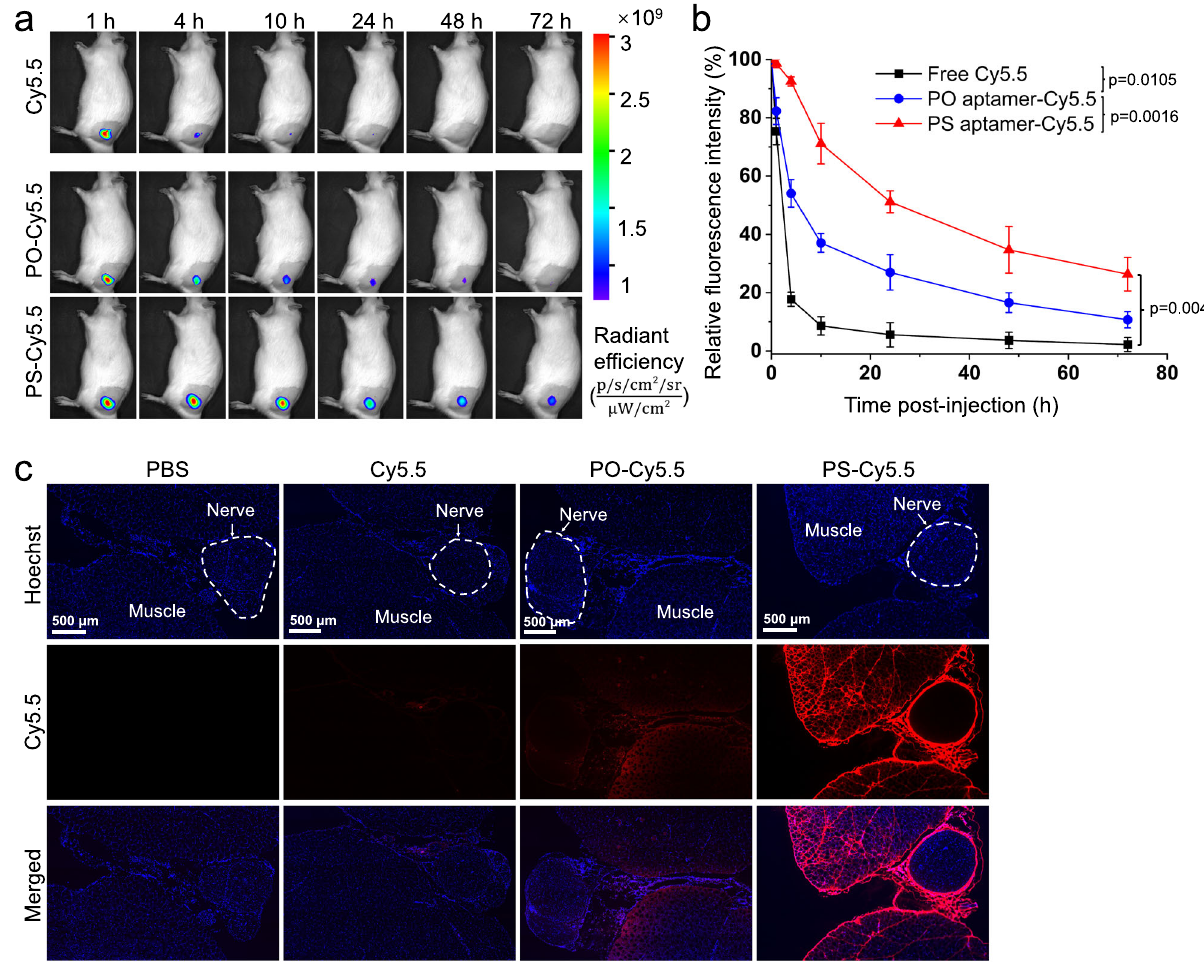
Fig. 3 | Tissue distribution of PS aptamer. a Representative time courses for the retentionofCy5.5-labelled aptamers(PO or PS)orfree Cy5.5atthe site ofinjection asmonitoredbyanIVIS.Colorrepresents fl uorescencefromCy5.5. b Quanti fi cation of the fl uorescence intensity over time (as a percentage of intensity at time=0, immediately after sciatic nerve injection), derived from data in panel ( a ). Data are means±s.d., n =4 rats per group. Statistical comparisons were performed